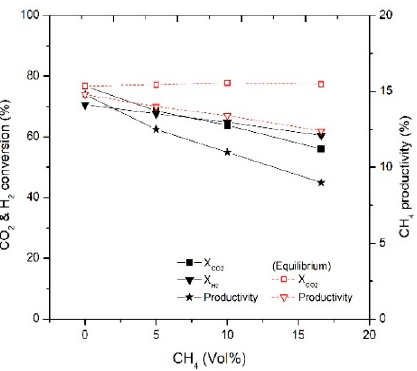
Figure 6. Effect of initial CH 4 concentration on CO 2 and H 2 conversion and CH 4 selectivity.